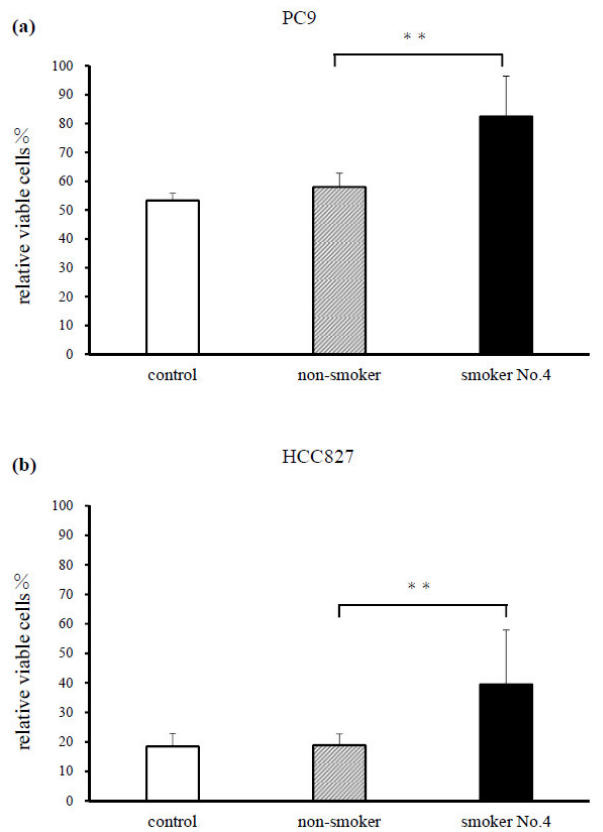
Figure 1. Treatment of ( a ) PC9 and ( b ) HCC827 cells with serum from a smoker reduces sensitivity to erlotinib therapy. Treatment of cells for 72 h with 1 µ M erlotinib and serum from smoker No. 4 (serum cotinine level: 488.4 ng/mL) resulted in a significant reduction of sensitivity to erlotinib compared with serum from a non-smoker control (serum cotinine level: 0.6 ng/mL) in both cell lines (** p < 0.001). Cell survival was assessed by using a cell-counting kit (CCK)-F. Results are means ± SEM of four independent experiments.